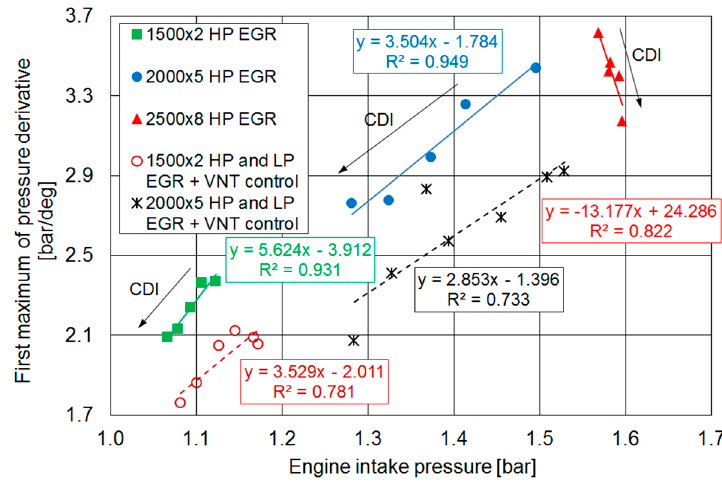
Figure 11. Link between engine intake pressure and first maximum of pressure derivative in different test sets.